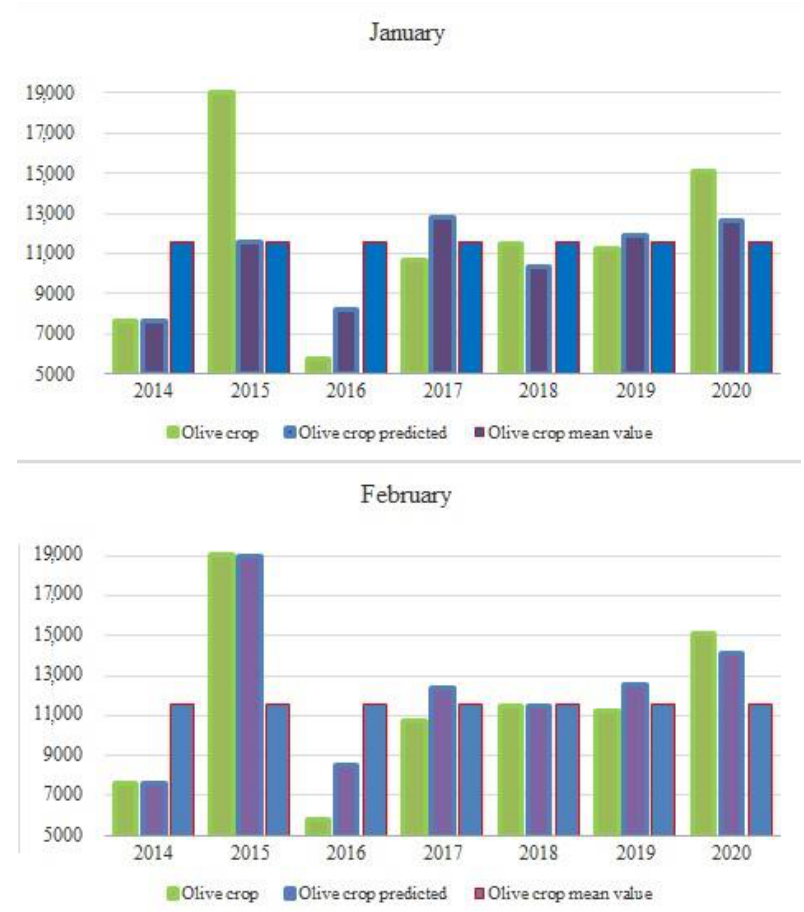
Figure 12. January and February yield data for all years studied: actual, predicted and averaged data.